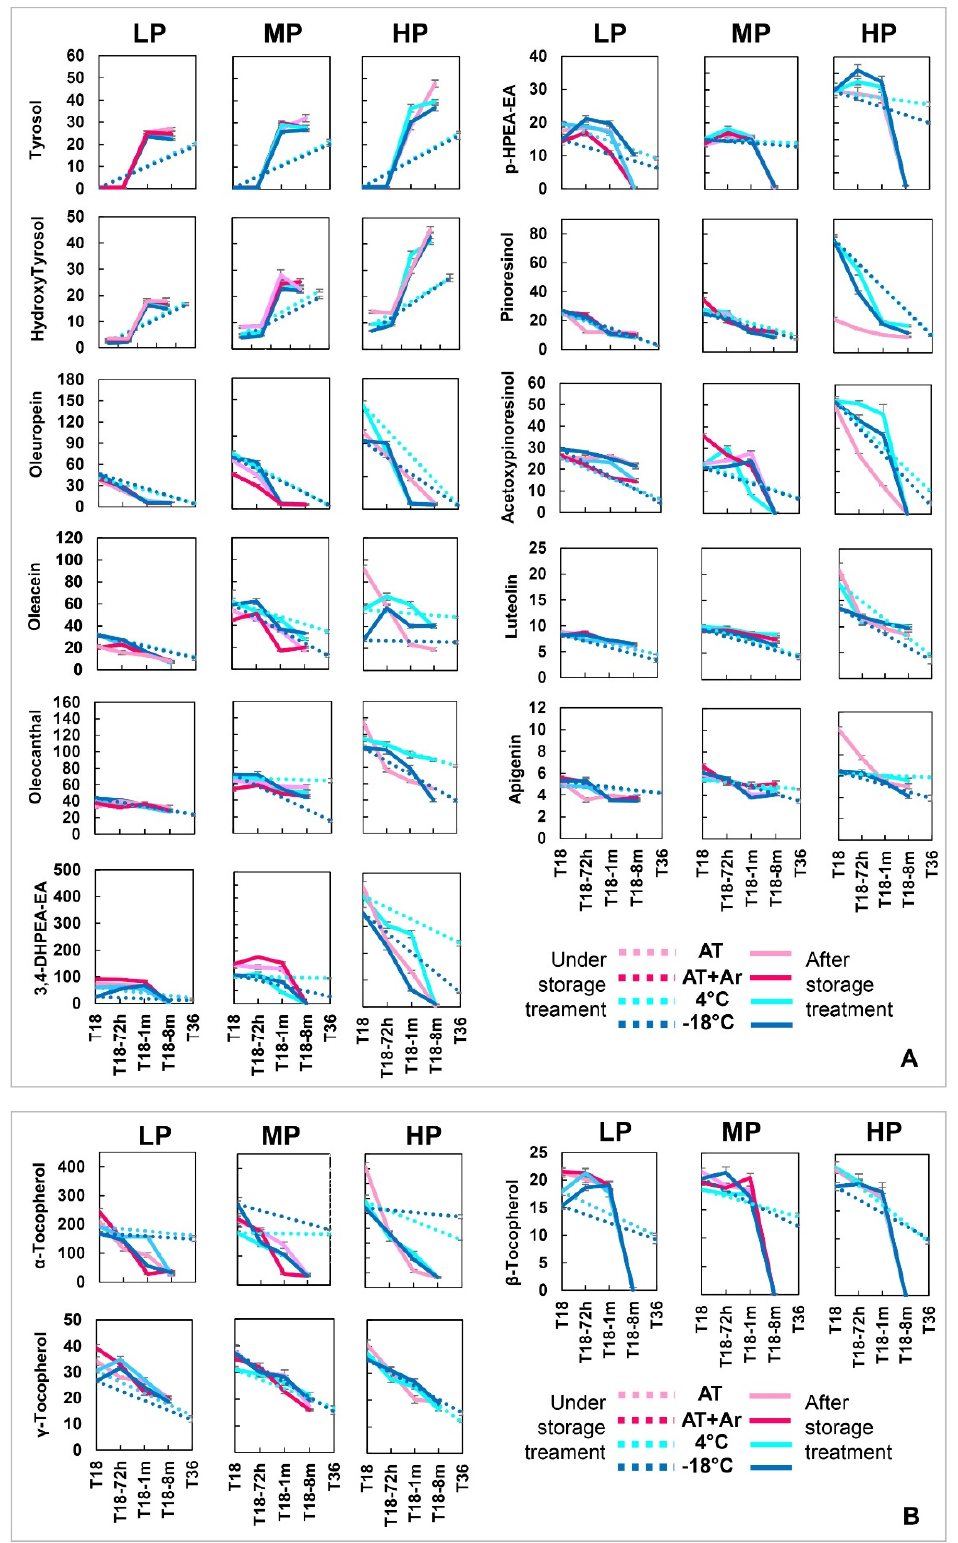
Figure 2. Evolution of phenolic compounds ( A ) and tocopherols ( B ) in LP, MP, and HP EVOOs under different storage conditions and time points. Dot lines: T18 and T36 (under storage treatment); solid lines: T18-72 h, T18-1 m, and T18-8 m (after storage treatment). All values are expressed in mg kg − 1 . Bars represent means ± SD of three replicates ( n =